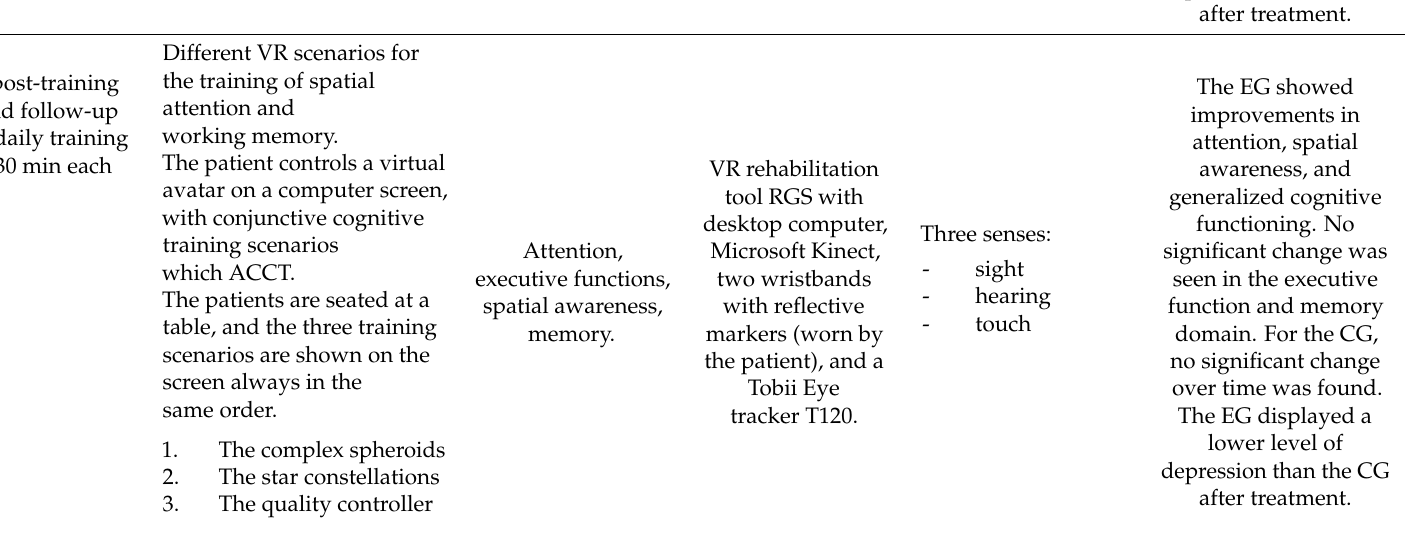
Attention, executive functions, spatial awareness,